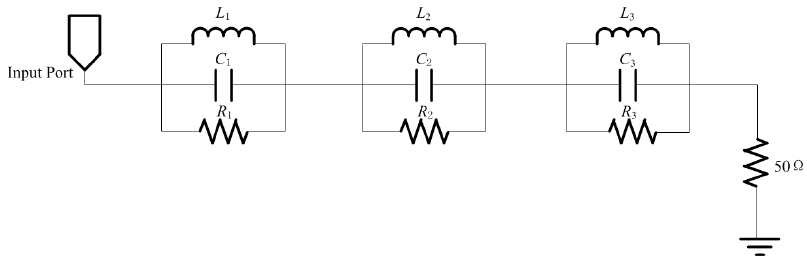
Figure 9. Simulated and measured results of the return loss of the proposed antenna.